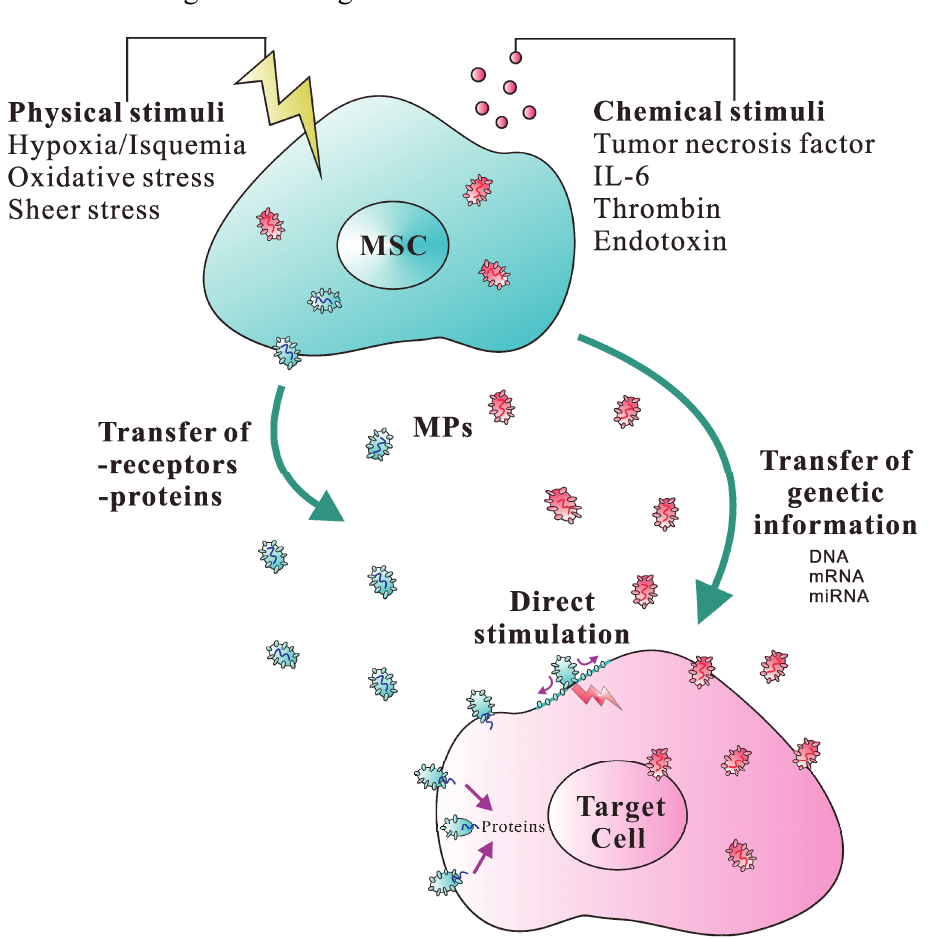
2. Schematic presentation of the mechanisms involved in MP-mediated intercellular communication. After MSCs are activated by physical and/or chemical stimuli, MPs are produced through the disruption of cytoskeleton. (a) MPs may transfer receptors or other proteins from the cell of origin to the target cell; (b) MPs may directly stimulate target cells through their cell membrane receptors; (c) MPs may convey genetic information by horizontal transfer of DNA, mRNA, miRNA or transcription factors to induce functional changes in the target